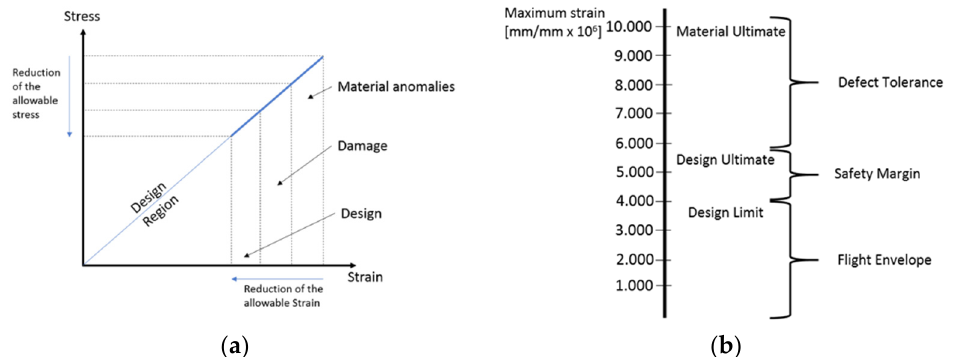
Figure 4. Schematic of scattering factors constraining the composite design ( a ) and Typical allowable design for CFRP ( b ).